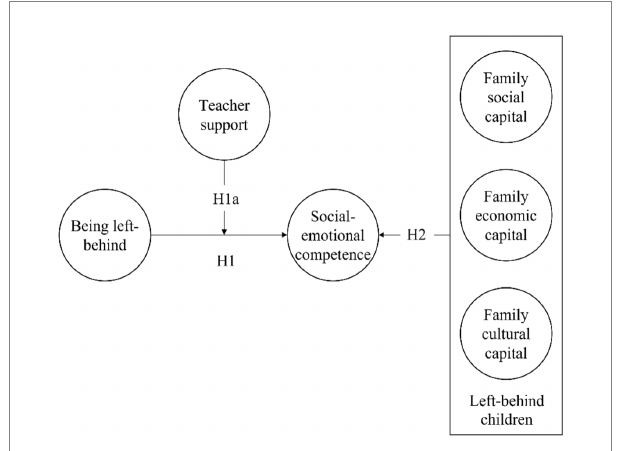
FIGURE 1 Conceptual framework of left-behind children